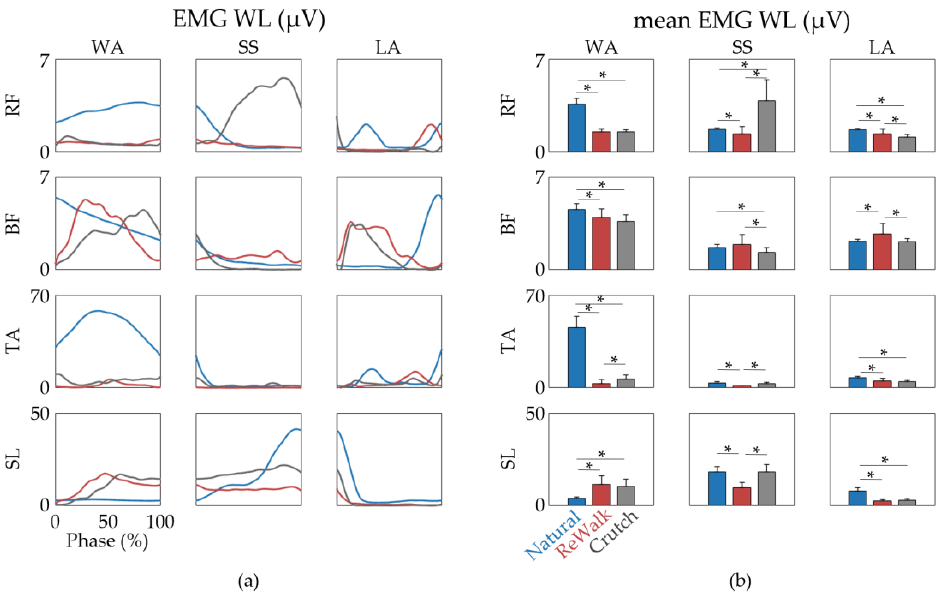
Figure 3. Comparison of EMG patterns in subject 1 divided according to the gait-related biomechanical phases. ( a ) Overlay of mean EMG WL during WA, SS, and LA phases obtained from ReWalk (red lines), natural (blue lines), and crutch (grey lines) gait conditions. ( b ) Bar graph representing the average EMG WL over the WA, SS, and LA phase periods. The data are shown as mean ± SD. Statistical significance was assessed by the Wilcoxon signed rank test (* denotes p < 0.05).